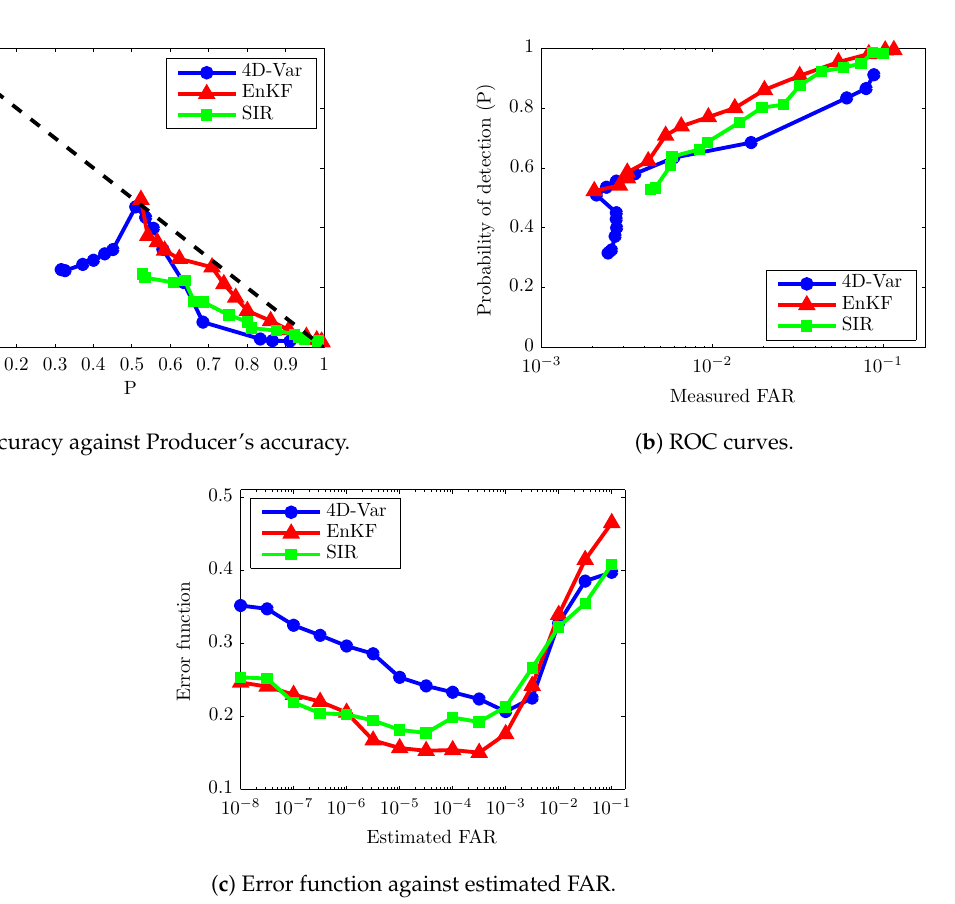
Figure 2. Error (cost) function, Precision-Recall curves and ROC